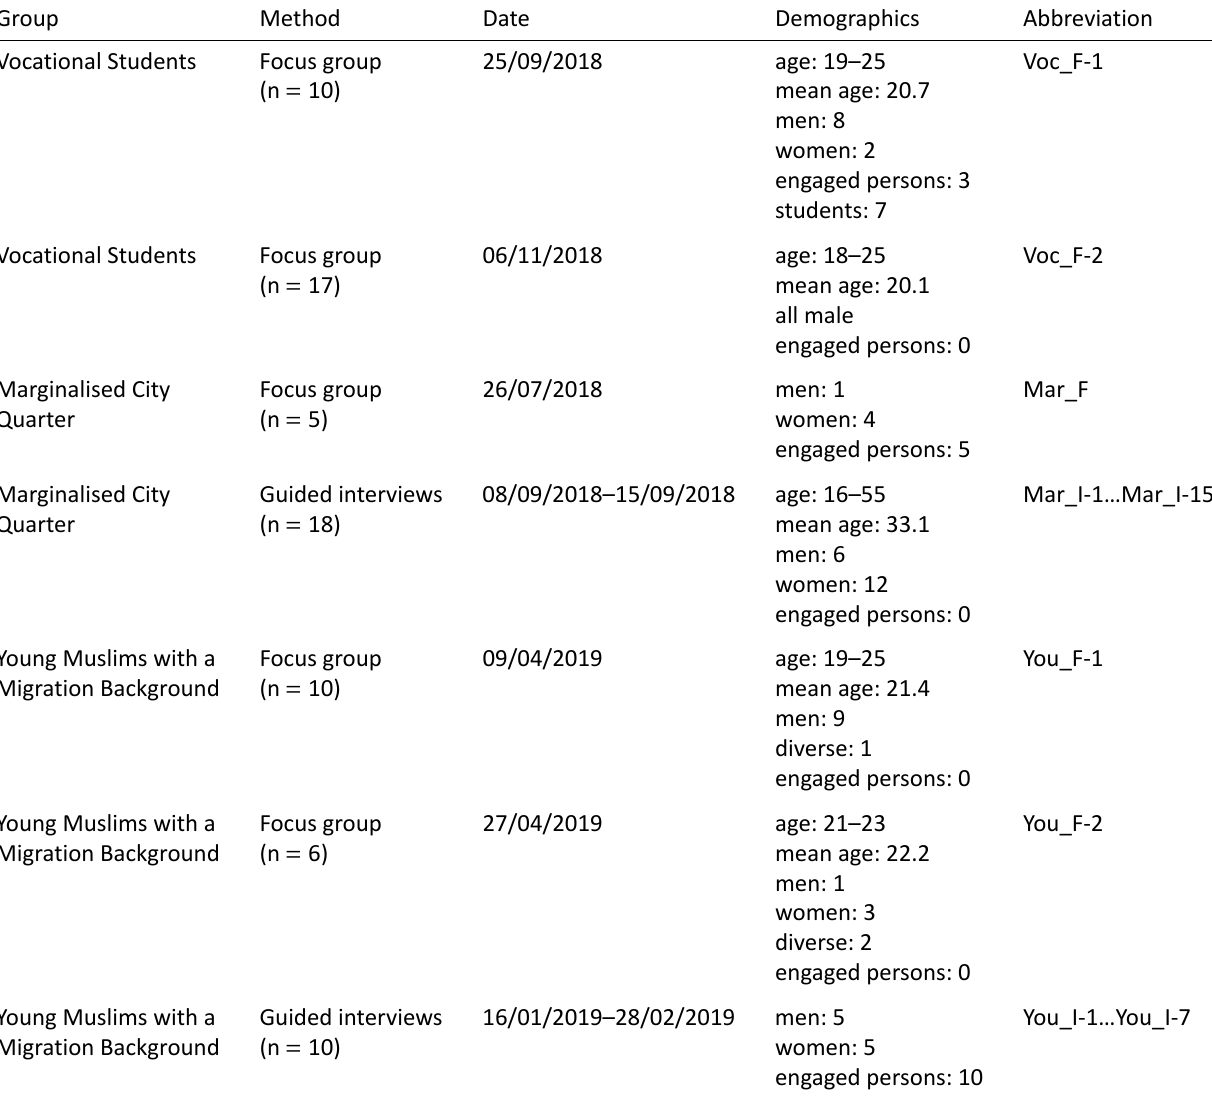
Table 1. Overview of the data basis.